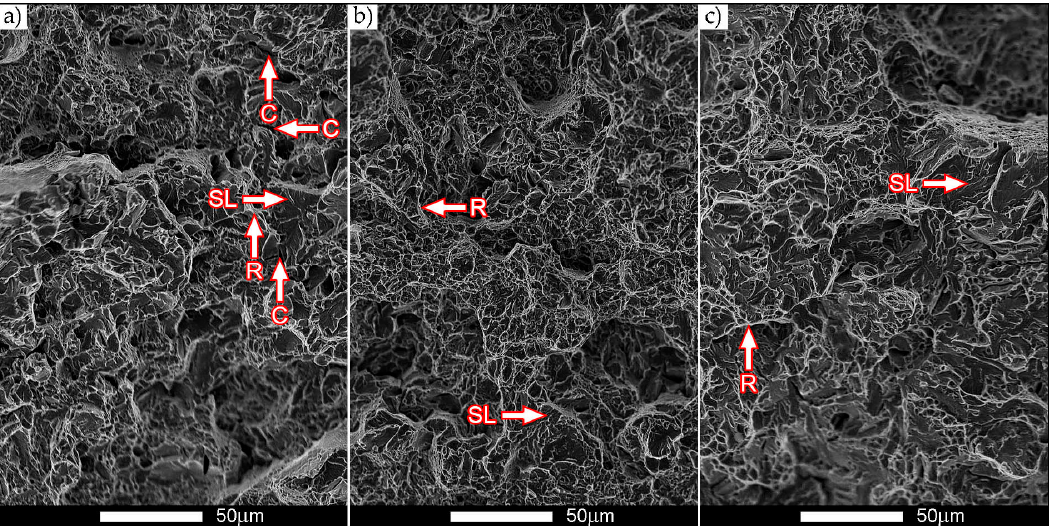
Figure 24, after impact testing at − 40 ° C. ( a ) Area marked with the frame A3; ( b ) area marked with the frame B3; ( c ) area marked with the frame C3. R—“river” system; SL—slides; C—microcracks with